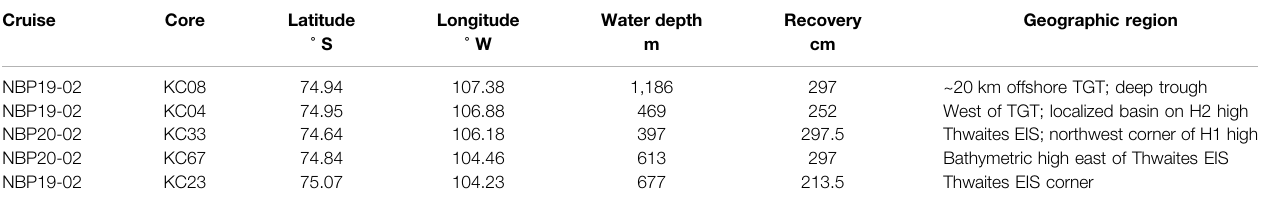
TABLE1| Location,waterdepth,andrecoveryofthe fi veNathanielB.Palmer(NBP)coresinvestigatedinthisstudy.BathymetrichighsH2andH1asde fi nedbyHoganetal. (2020). KC = Kasten core; TGT = Thwaites Glacier Tongue; EIS = Eastern Ice Shelf.